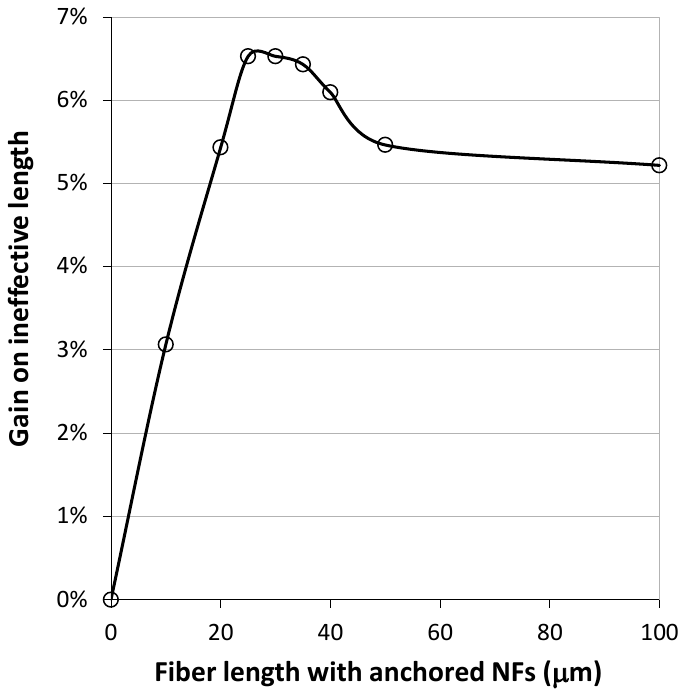
Figure 10. Gain on the ineffective length with a partial distribution of NF network in the fiber interspace, with effective modeling of NF network reinforcing